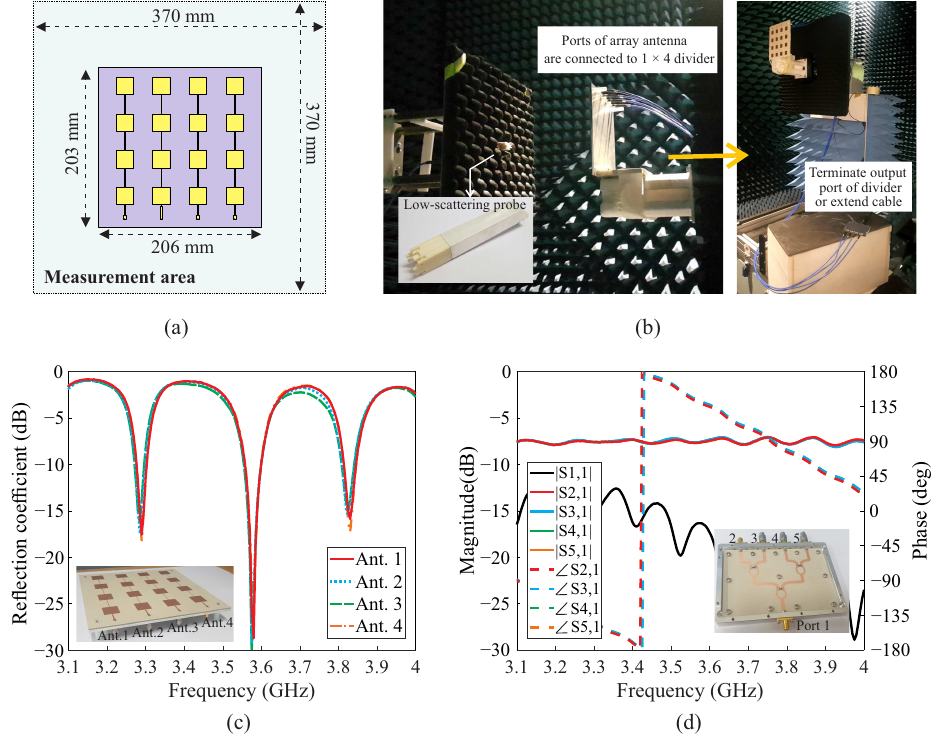
Figure 7. ( a ) Configuration of tested array antenna and measurement information, ( b ) measurement environment, ( c ) measured reflection coefficients of array antenna, and ( d ) measured S-parameters of 1 × 4 Wilkinson power